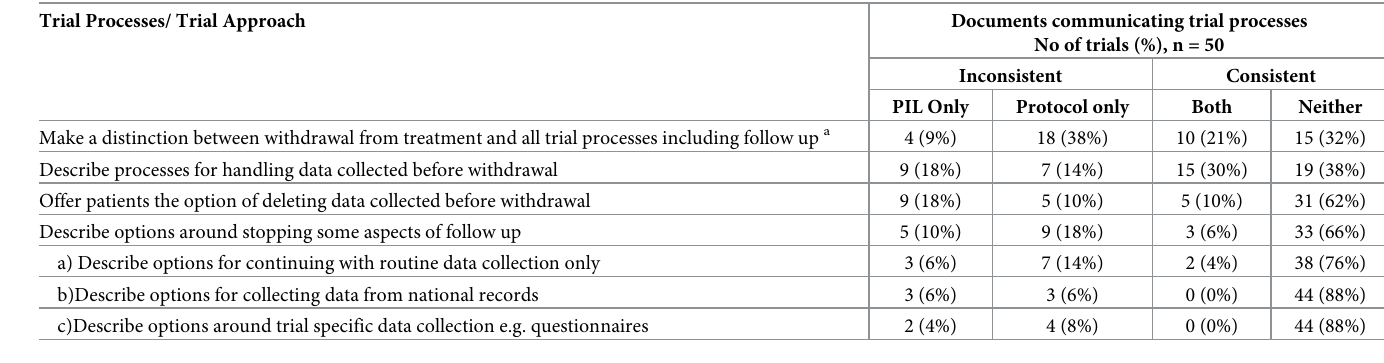
Table 4. Consistency of retention communication between trial